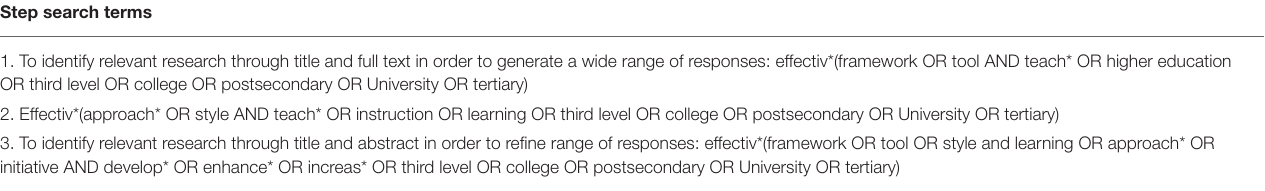
TABLE 1 | Sample of search terms for the ERIC database.